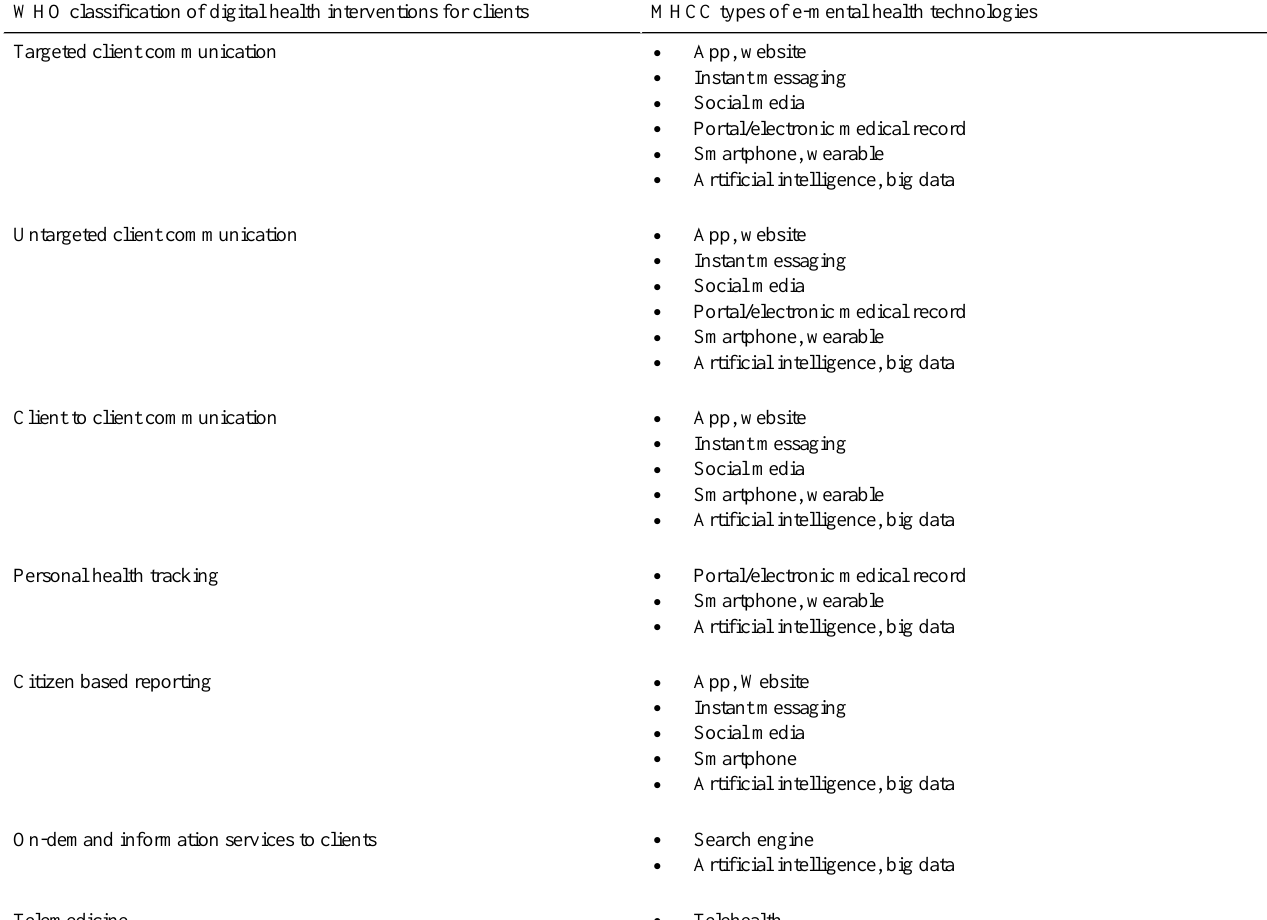
Table 1. Mapped classification of digital health interventions using the Mental Health Commission of Canada (MHCC) and World Health Organization (WHO) technology